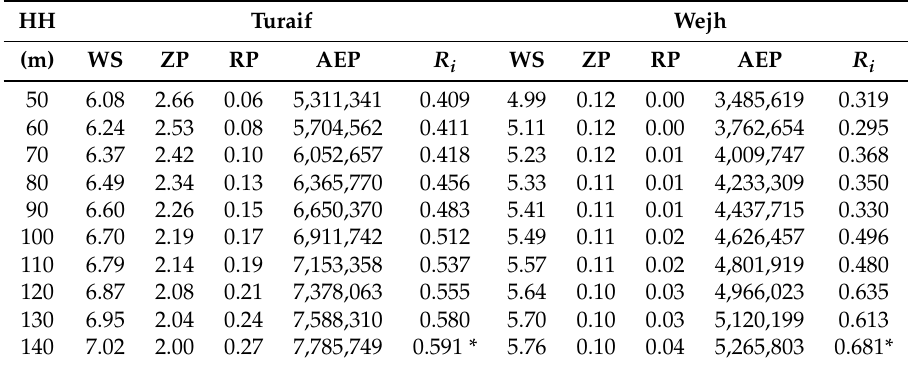
Table A2. TOPSIS analysis for turbine Alstom ECO 100/2000 Class I. The best choice for each site is marked with an asterisk.